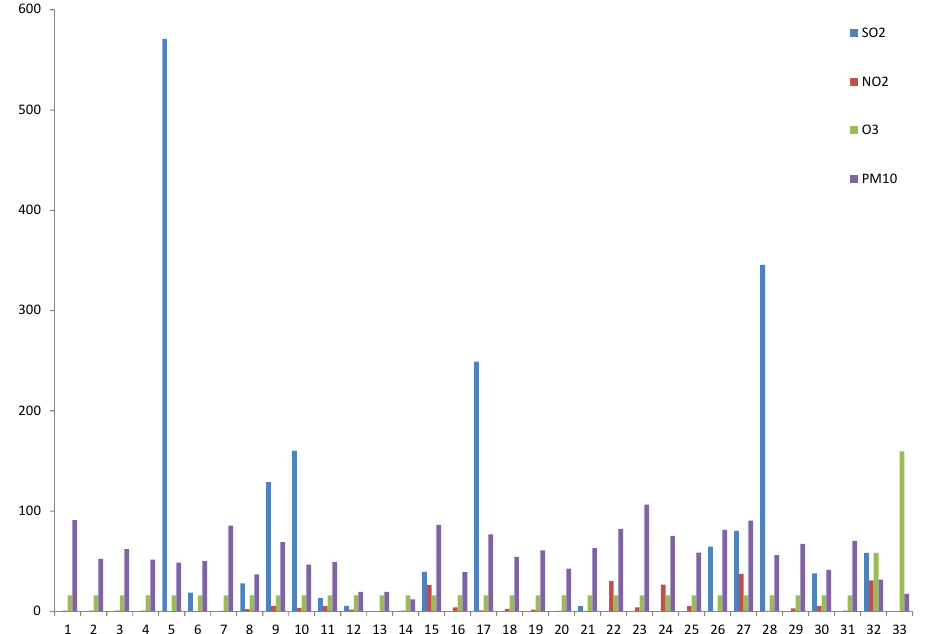
Figure 1. Overall mean concentrations of PM 10 , NO 2 , O 3 , and SO 2 collected over the 10-day period for each school.